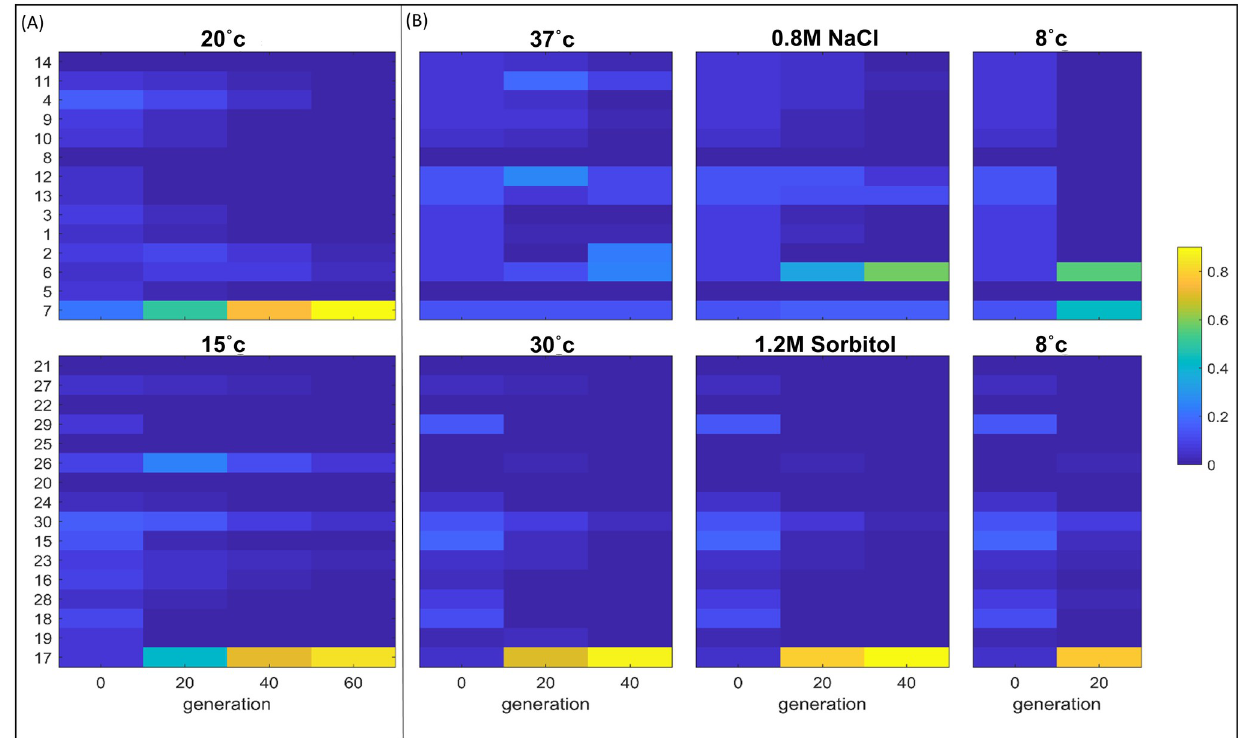
Fig 4. Pooled competition. Strains were mixed and grown for several dozens of generations in serial dilution regimes under different growth conditions (see S3 Text for details). At different time points during the competition, barcodes were sequenced, and their frequencies are shown. (A) Challenge conditions to which strains were evolved (15˚C and 20˚C for E . coli and S . cerevisiae , respectively). Color bar represents the frequency of the strains barcode reads from total number of reads. (B) Other challenges (“evolutionary memory,” 37˚C and 30˚C for E . coli and S . cerevisiae , respectively; “generalization,” 0.8M NaCl and 1.2M sorbitol for E . coli and S . cerevisiae ; “extremity,” 8˚C for both E . coli and S . cerevisiae) . Color bar represents the frequency of the strains barcode reads from total number of reads. Upper panels present E . coli competition results; lower panels present S .